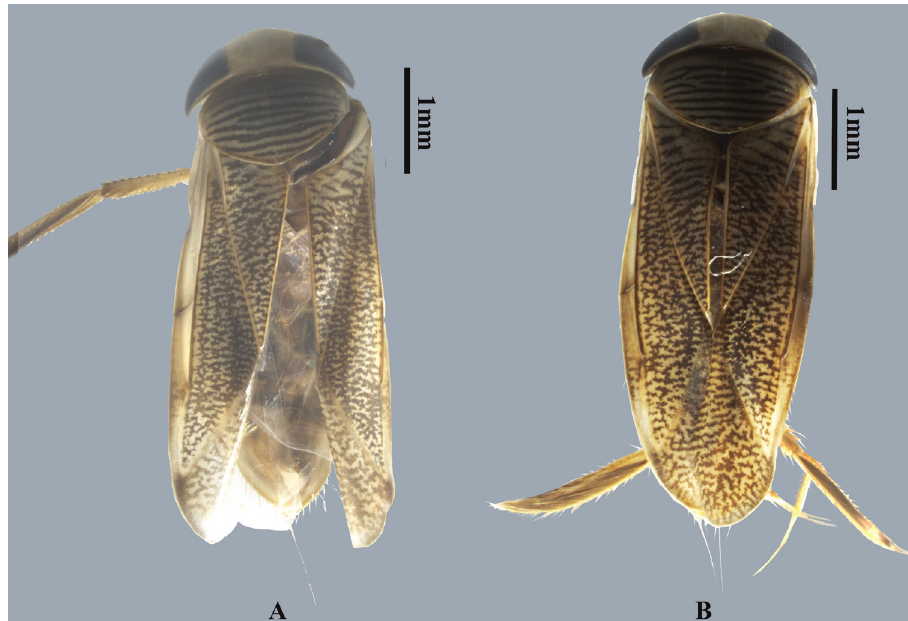
Figure 1. Dorsal habitus of Cenocorixa yuanjiangensis sp. nov. A male B